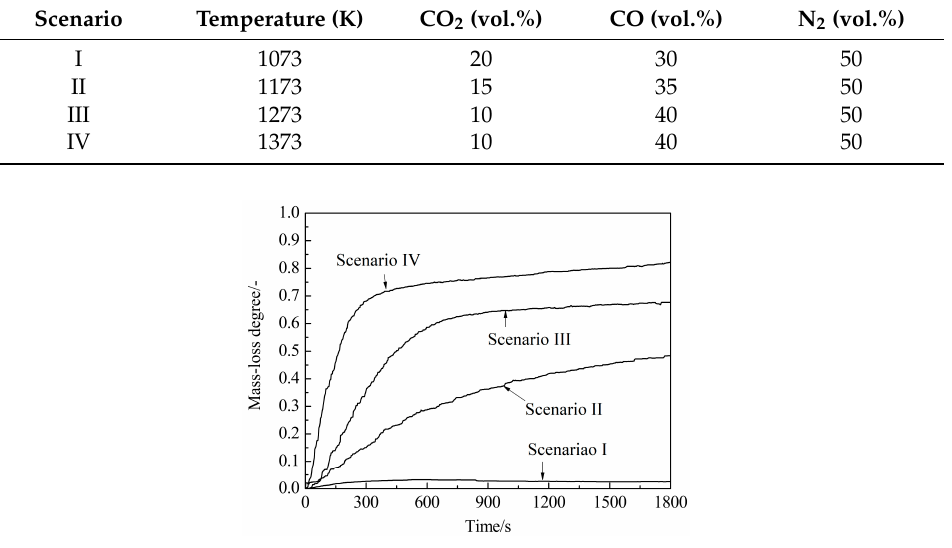
Table 4. Scenarios for the isothermal CCB reaction tests (30 min).